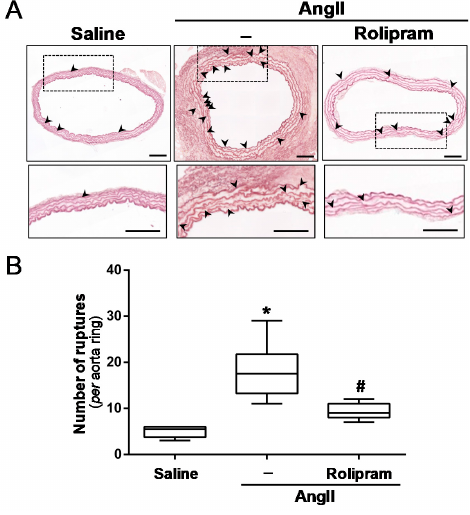
Figure 7. Rolipram attenuates the vascular remodelling induced by AngII in ApoE − / − mice. ApoE − / − mice were infused with saline solution or AngII (1000 ng/kg/min) for 28 days. The mice challenged with AngII were treated or not with rolipram (3 mg/kg/day). ( A ) Representative images showing the structure of the elastin fibres in the abdominal aortas after orcein staining. The arrowheads indicate elastin ruptures (Bars: 100 µm). ( B ) The boxplot shows the quantitative analysis of the number of ruptures in the elastin fibers per aortic section. The box extends from the 25th to the 75th percentile, and the median is indicated by a horizontal line. The whiskers represent the maximum and minimum values (saline-infused mice n = 6; AngII-challenged mice, n = 12; AngII-challenged mice treated with rolipram, n = 7). p < 0.05: * vs. saline-infused mice; # vs. AngII-challenged mice.